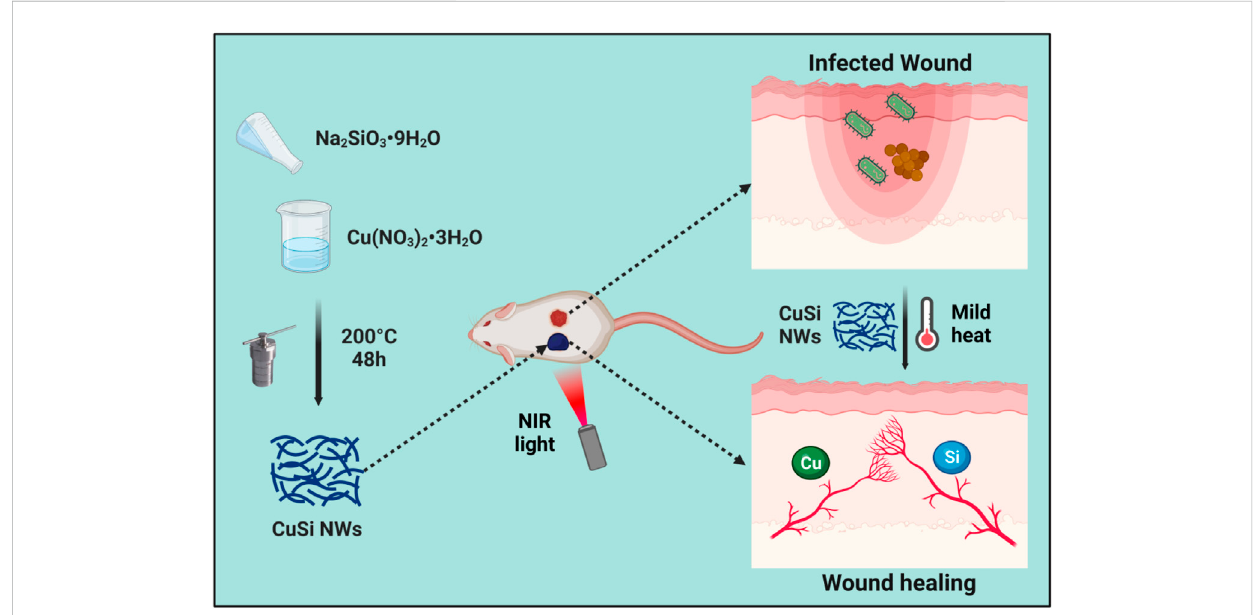
FIGURE 1 CuSi NWs with light-to-heat conversion capability was designed to effectively combat bacteria and simultaneously promote angiogenesis, thereby improving the wound healing rate of infected wounds. The fi gure was created with